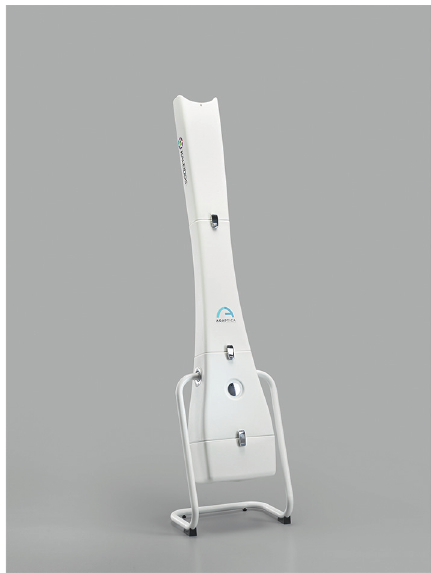
Figure 1: The 2WIN-S includes a photorefractometer (2WIN) and an occluder